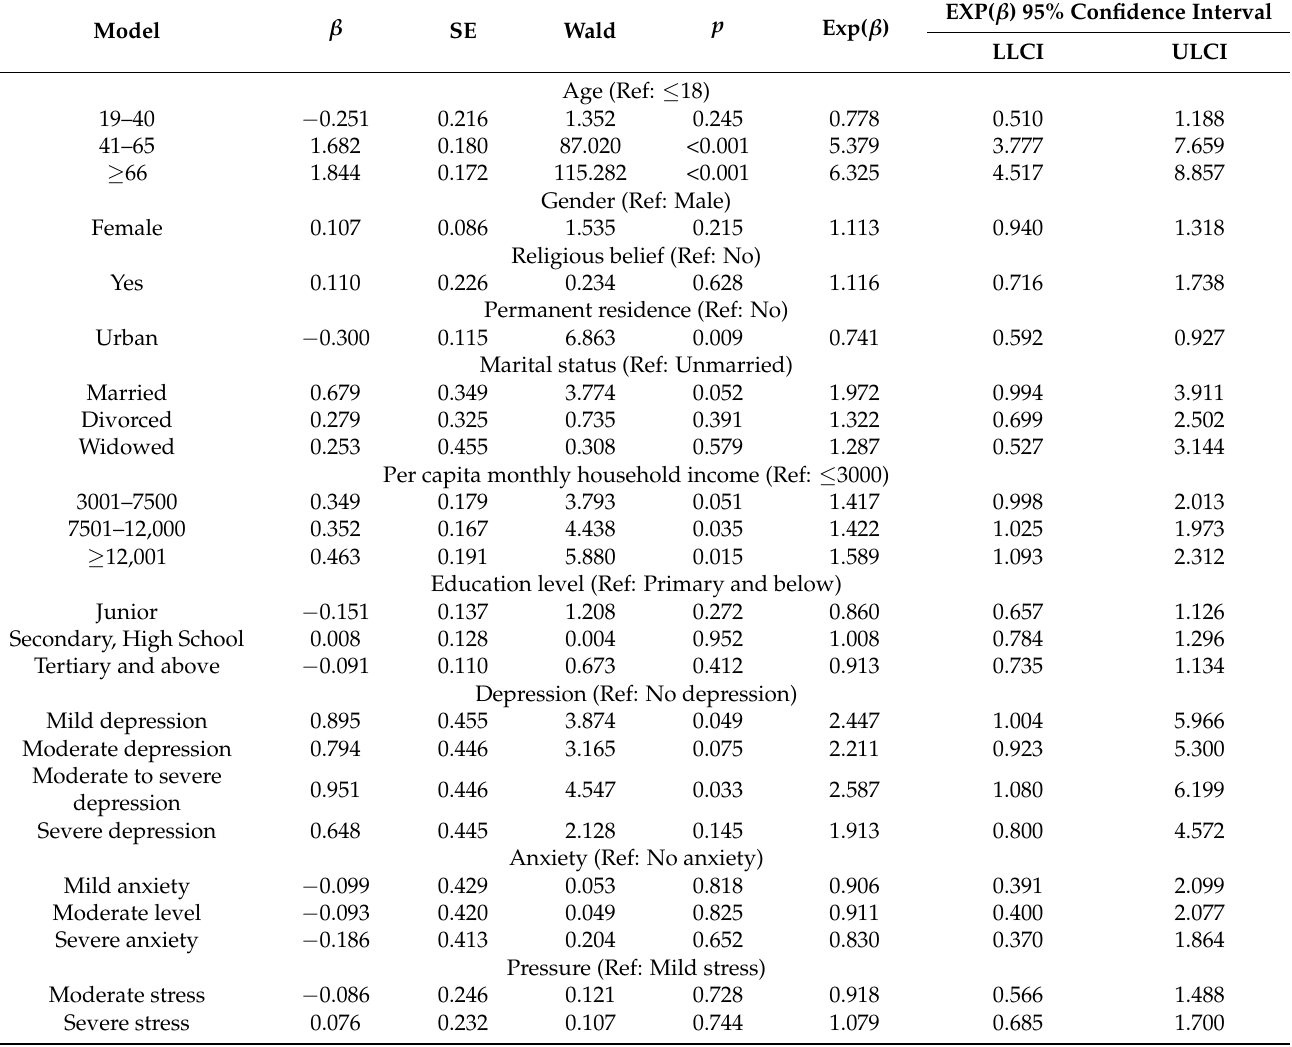
Table 6. Binary logistic regression analysis of COVID-19 vaccination in the media use